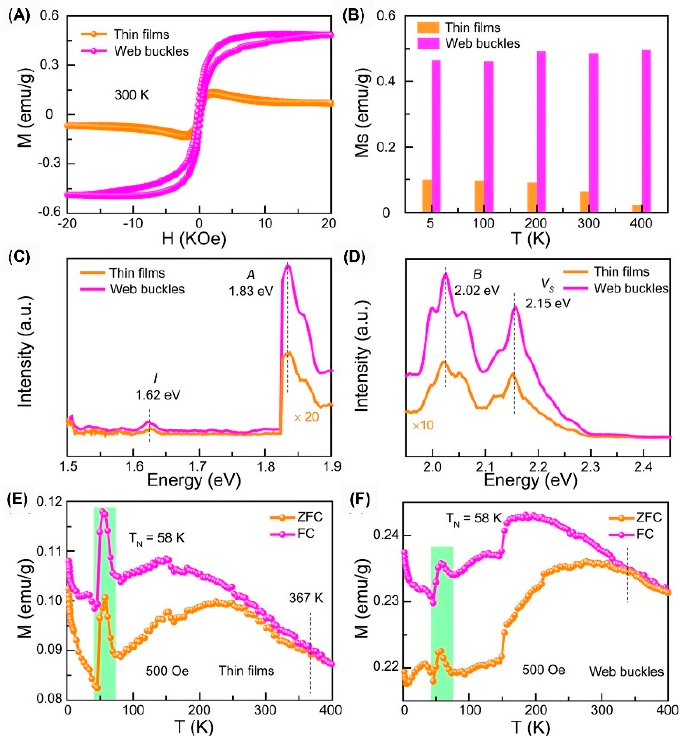
Figure 7. Ferromagnetism of MoS 2 thin films and web buckles. M-H curves ( A ), M s –T ( B ), FL excitation spectra ( C ), and FL emission spectra ( D ) of MoS 2 thin films and web buckles. ( E , F ) M s –T of MoS 2 thin films and web buckles. (Reprinted/adapted with permission from Ref. [72]. Copyright 2020, American Institute of Physics).